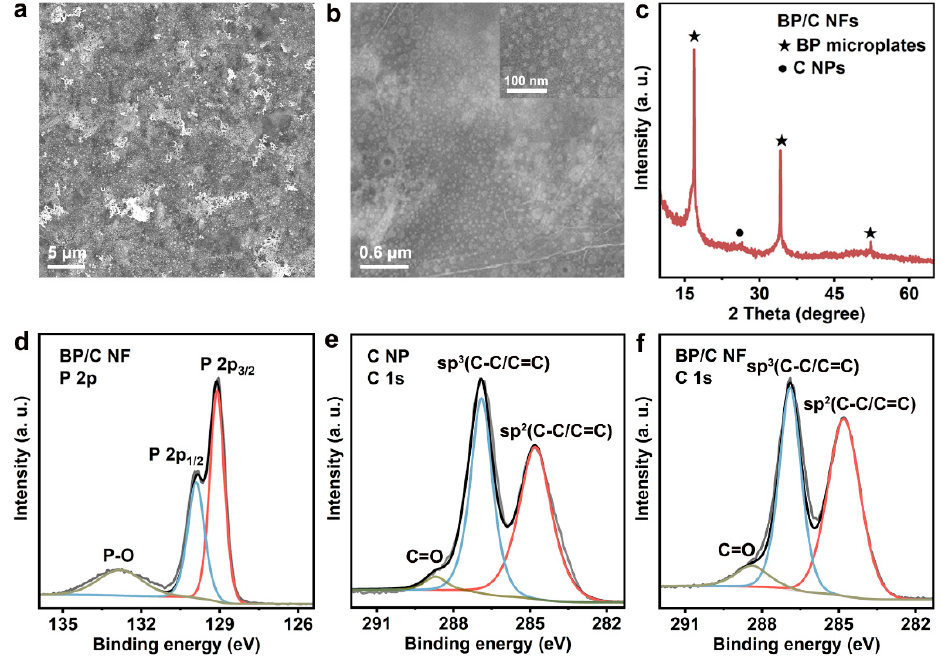
Figure 2. Characterization of BP/C NFs. ( a , b ) SEM images of BP/C NFs under different magnifica- tions. ( c ) XRD pattern of BP/C NFs. ( d – f ) XPS spectra of ( d ) P 2p for BP/C NF, ( e ) C 1s for C NP, and ( f ) C 1s for BP/C NF.